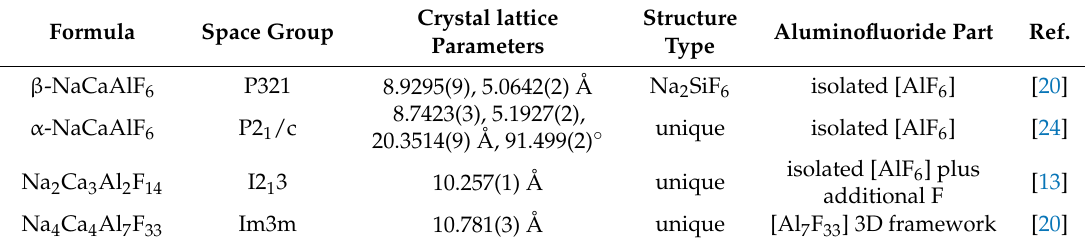
Table 4. Crystal structure data for the ternary phases from the NaF–CaF 2 –AlF 3